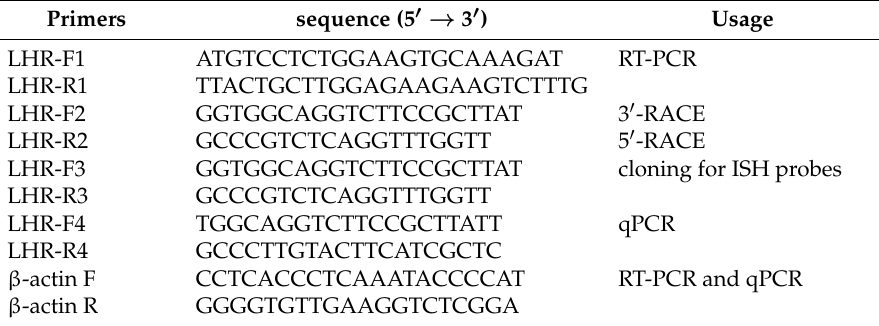
Table 1. Primers used in this